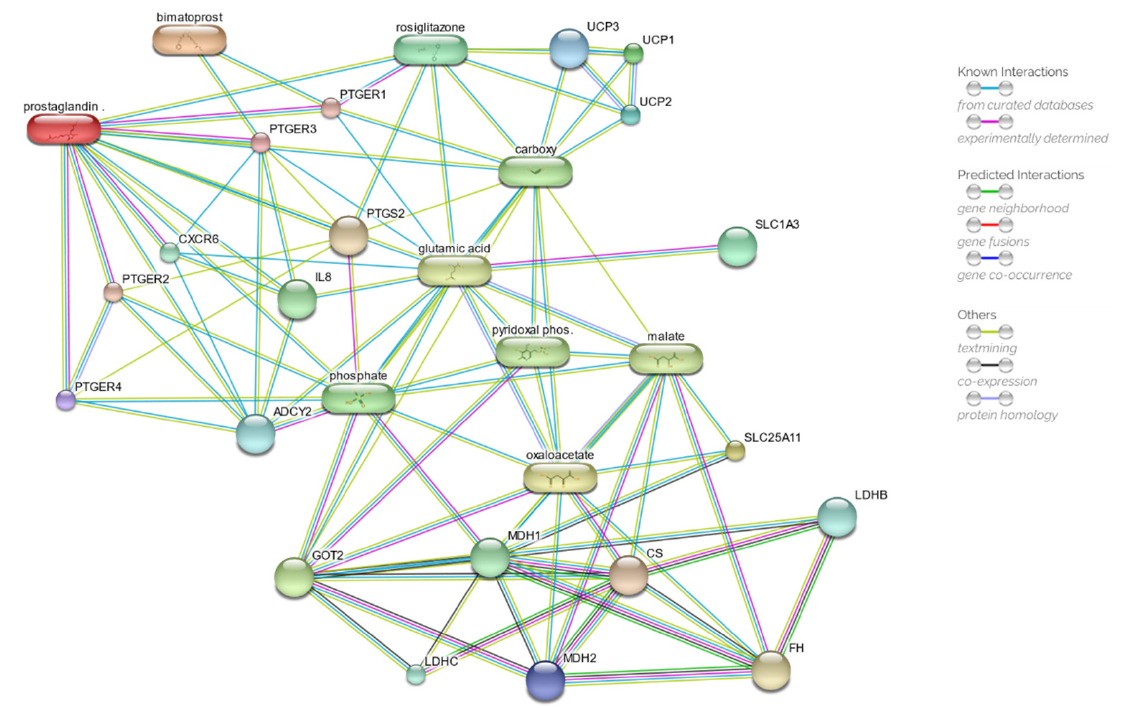
Figure 6. Drug–target network, obtained by STITCH database, of prostaglandin E2 (PGE 2 ) and bimatoprost. Chemicals are represented as pills; proteins are represented as spheres. ADCY2, adenylate cyclase 2; CS, citrate synthase; CXCR6, chemokine (C-X-C motif) receptor 6; FH, fumarate hydratase; GOT2, mitochondrial glutamic-oxaloacetic transaminases 2; IL8, interleukin 8; LDHB, lactate dehydrogenase B; LDHC, lactate dehydrogenase C; MDHs, malate dehydrogenases; PTGERs, prostaglandin E receptors; SLC1A3, solute carrier family 1, member 3; SLC25A11, solute carrier family 25, member 11; UCPs, uncoupling proteins. More detailed information and the interactive network can be retrieved at the link: http://stitch.embl.de/cgi/network.pl?taskId=XymGQyDgGV6u (accessed on 11 November 2022).